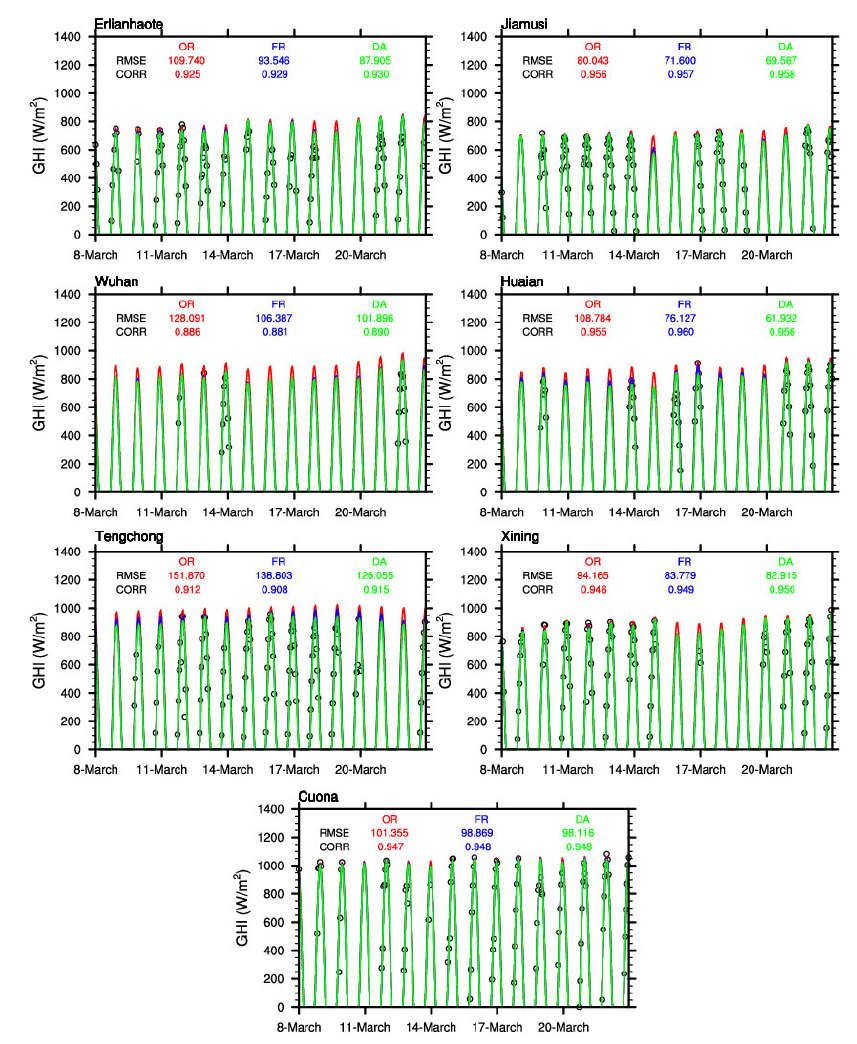
Figure 9. Time series of the observed and simulated hourly GHI under clear skies for the OR, FR, and DA experiments in seven typical rural and suburban stations from 8 to 22 March 2021.